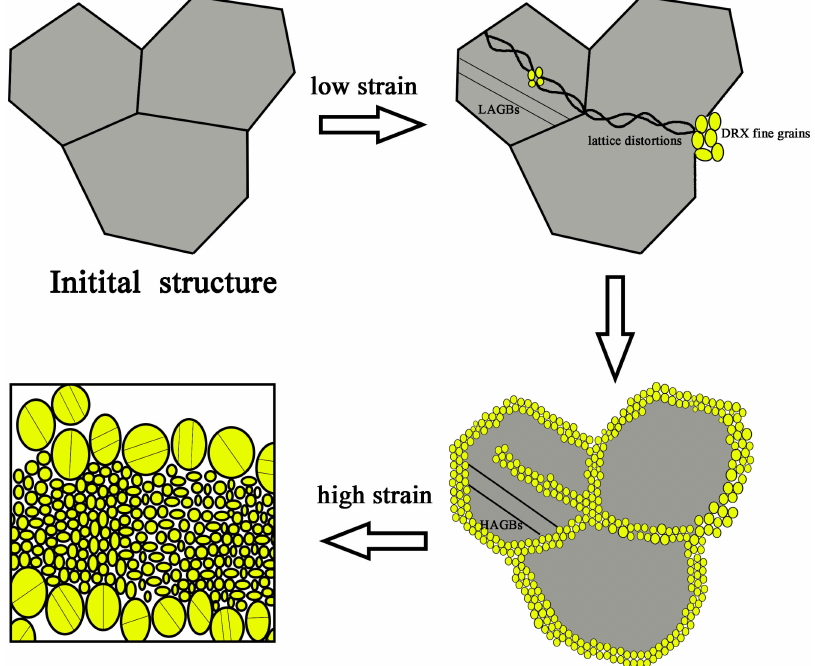
Figure 12. Schematic diagram of grain refinement during the CEE-AEC